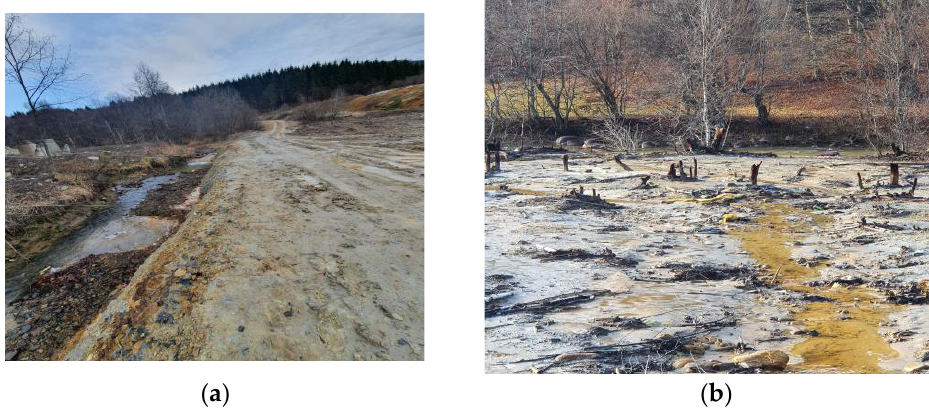
Figure 4. Leaks from the Bloaja dump directed on the gutter and in the Lăpuș River, Băiuț area, Maramures county, Romania (photos: I.A.P.): ( a ) Leaks in the gutter downstream of the sterile dump; ( b ) Concentrate and acid water flowing into the Lăpuș